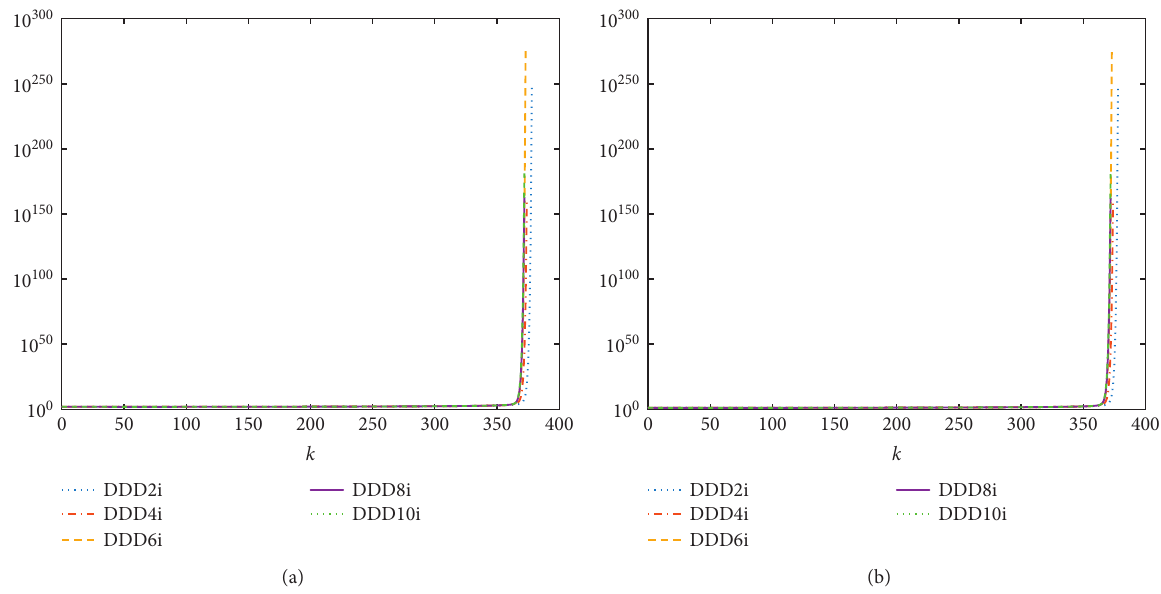
Figure 11: Residual error trajectories synthesized by five DDD algorithms for example 2 (with ϵ � 0 . 001 s and c � 1 . 0). (a) Trajectories of ‖